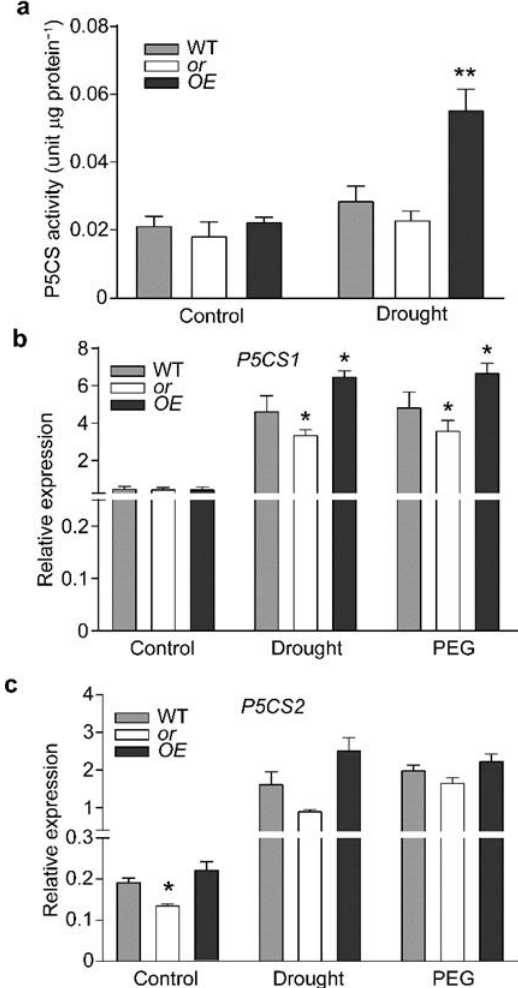
Figure 6. OR affects P5CS expression, in response to drought treatment. ( a ) P5CS activity in the wild-type (WT) and OR -overexpressing ( OE ) and -silencing ( or ) 4-week-old seedlings, under normal growth condition and drought treatment, for 7 d. ( b , c ) Transcript abundances of P5CS1 ( b ) and P5CS2 ( c ) in the WT, OE , and or seedlings, under normal growth conditions (control) or treated by drought or 10% PEG6000, for 7 d. Data are means ± SEM ( n = 3, * p < 0.05, ** p < 0.01, or better, Student’s t test).